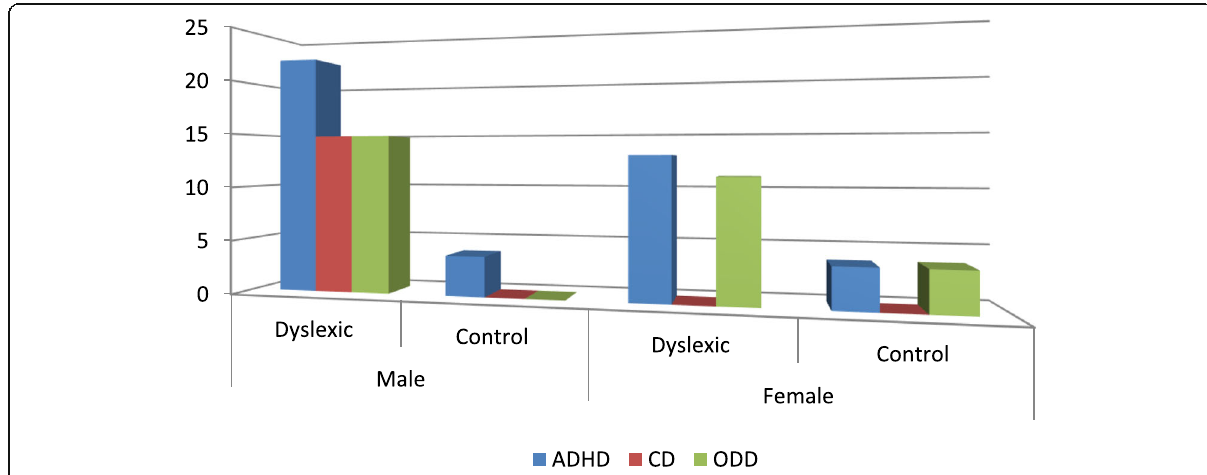
Fig. 2 Frequency distribution of ADHD, CD, and ODD in boys and girls of studied group according to MINI kids scale